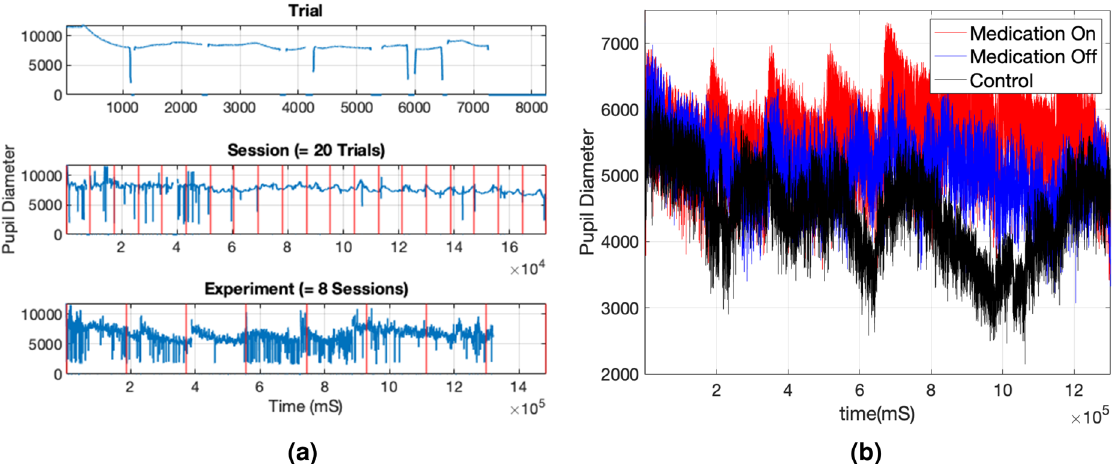
Figure 1. A sample pupil diameter dataset collected over a trial, session (20 trials) and an experiment (8 sessions) ( a ) and pupil diameter of the three groups ( ADHD-on-medication , ADHD-off-medication , and controls ) averaged over the number of 160 trials ( b